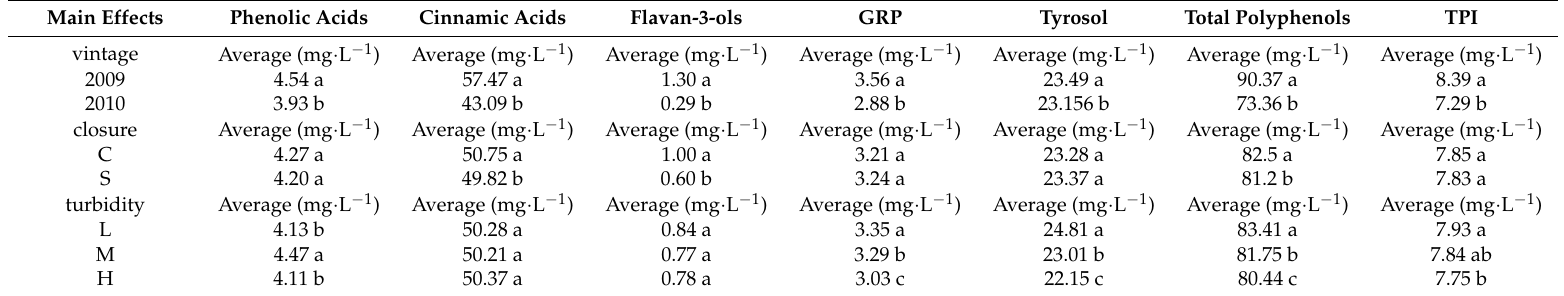
Table 7. Results of the Newman-Keuls’ test ( α = 5%) performed on the concentration of polyphenols for 2009 and 2010